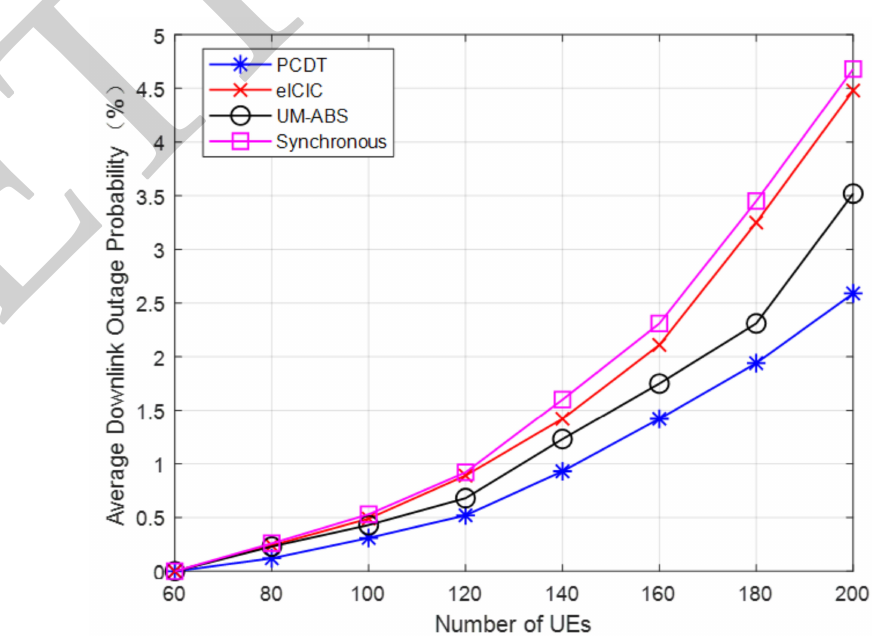
Figure 9. The comparison on the average downlink outage